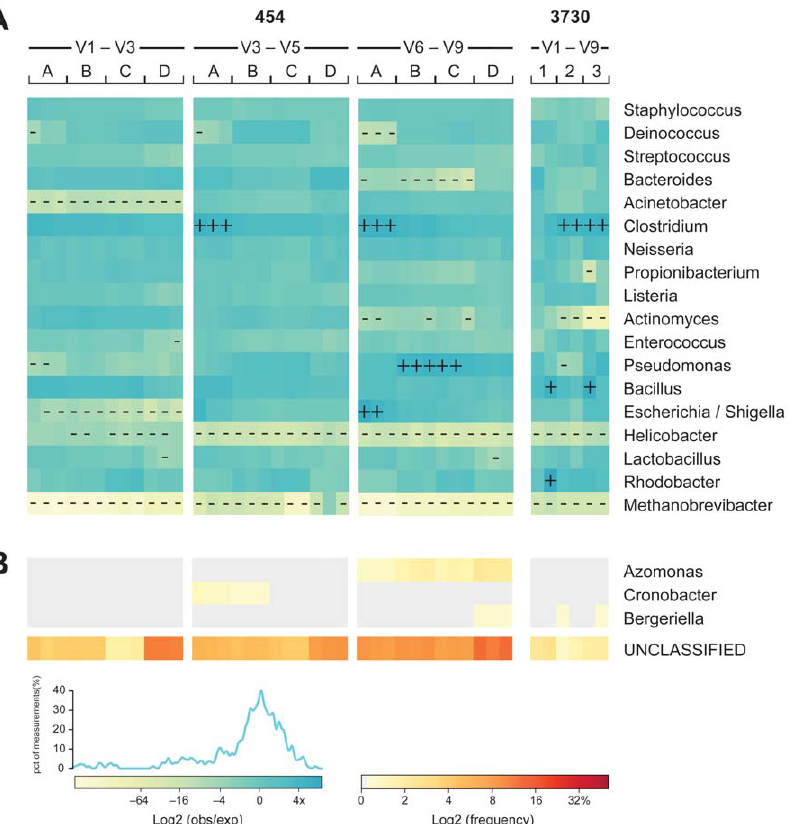
Figure 3. Mock community-based accuracy of community representation compared across technology and 16S window. The MC was sequenced by different centers on both 3730 and 454 platforms. Each sequencing trial is represented as a column. For 3730 sequencing of the V1–V9 window, amplicons derived from a common amplification protocol were sequenced with short capillaries (1), long capillaries (2), and three reads per clone (3). 454 sequencing was performed by four centers (A, B, C, and D) with three 16S windows (V1–V3, V3–V5, and V6–V9). (A) The observed genus- level frequency data over expected genus-level frequency ratio for each of the MC members is shown as a heatmap using a binary logarithm scale. The expected frequency ratio is based on the whole genome coverages inferred from mapped Illumina WGS reads to the MC reference genome sequences. Genera with observed frequencies differing more than four-fold from expected are marked with + or – for over- or under-representation, respectively. (B) The fraction of misclassified (0.1% of the total combined data set) and unclassified (4.6% of the total combined data set) sequences displayed as a frequency heatmap. The frequency values are depicted as a binary logarithm scale.